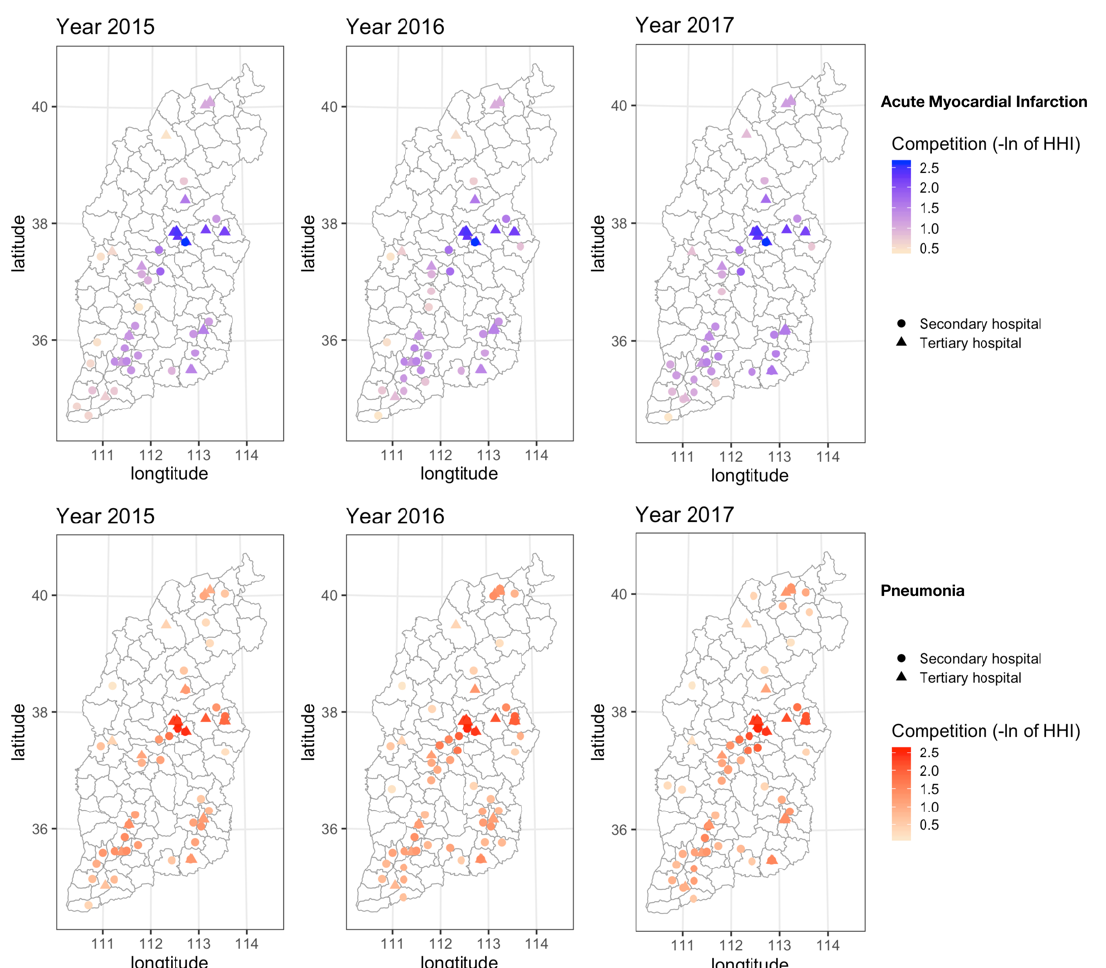
Figure 2. Geographical distribution of hospital competition for acute myocardial infarction and pneumonia in Shanxi, 2015 – 2017. Table 2. Random-intercept logistic regression: estimates of hospital competition effect on quality.